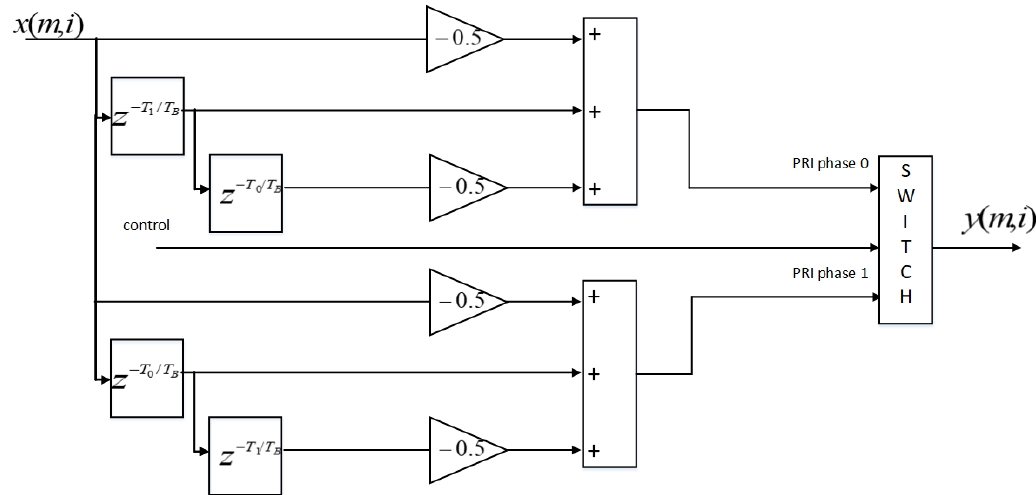
Figure 6. Switched implementation of the staggered pulse repetition interval (PRI) moving target indication (MTI) filter. The numbers 𝑚 and 𝑖 are indices of the RX antenna elements along the x and z axes (please refer to Figure 8 of [27]).